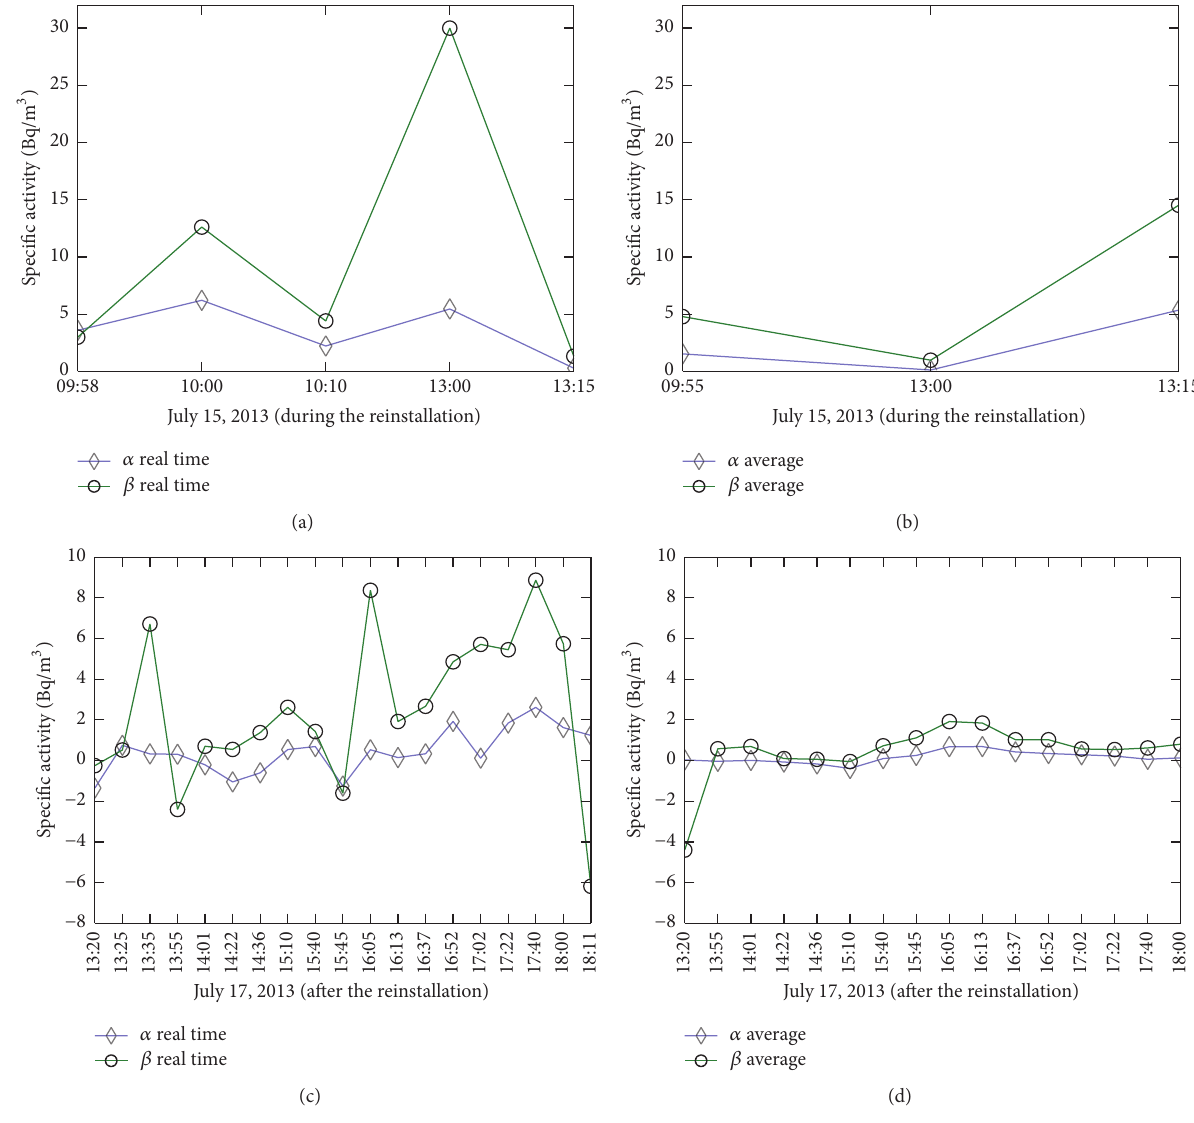
Figure 9: The specific activity of aerosol during and after the reinstallation of the helium circulator. (a) The online monitoring data during the reinstallation; (b) the temporally averaged data during the reinstallation; (c) the online monitoring data after the reinstallation.